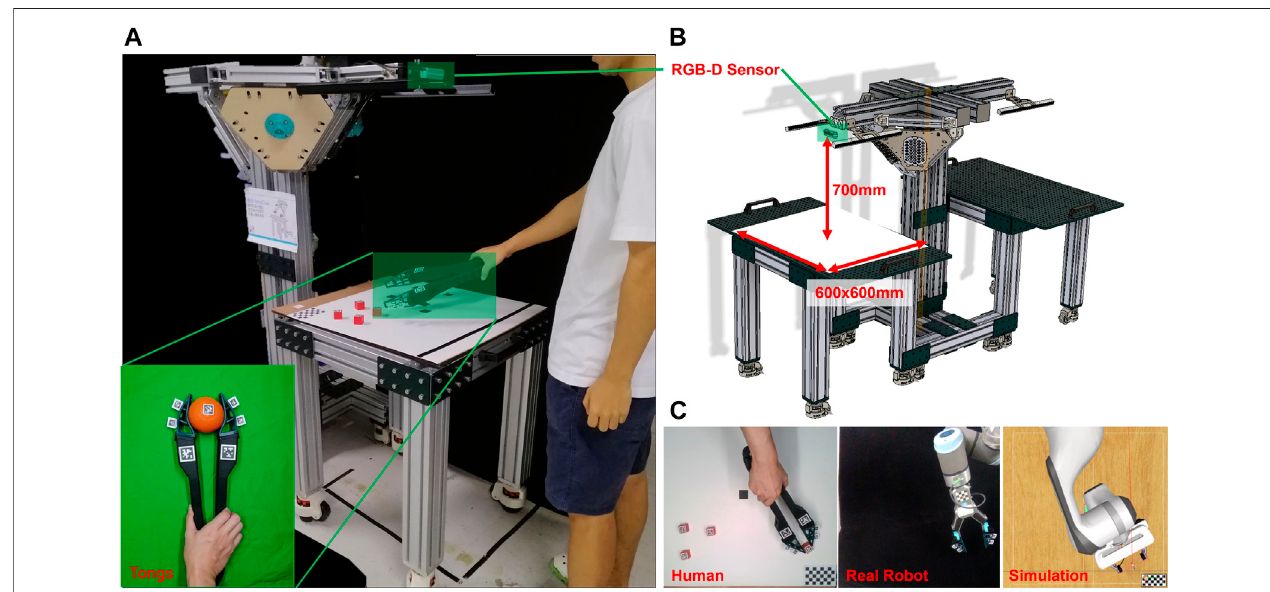
FIGURE 1 | Design overview of DeepClaw 2.0 for collection human manipulation data. As shown in (C) : manipulation data collected from a human teacher who operates a pair of modi fi ed kitchen tongs can be applied in imitation learning for robot in simulated or real environment. As shown in (A) an (B) : RGB-D sensor (Intel RealSense 435i is used in this paper) is fi xed on the top, 700 mm away from the operating platform. Working space is a square with 600 × 600 mm. The origin of world coordinates is set in the left-top corner located by a